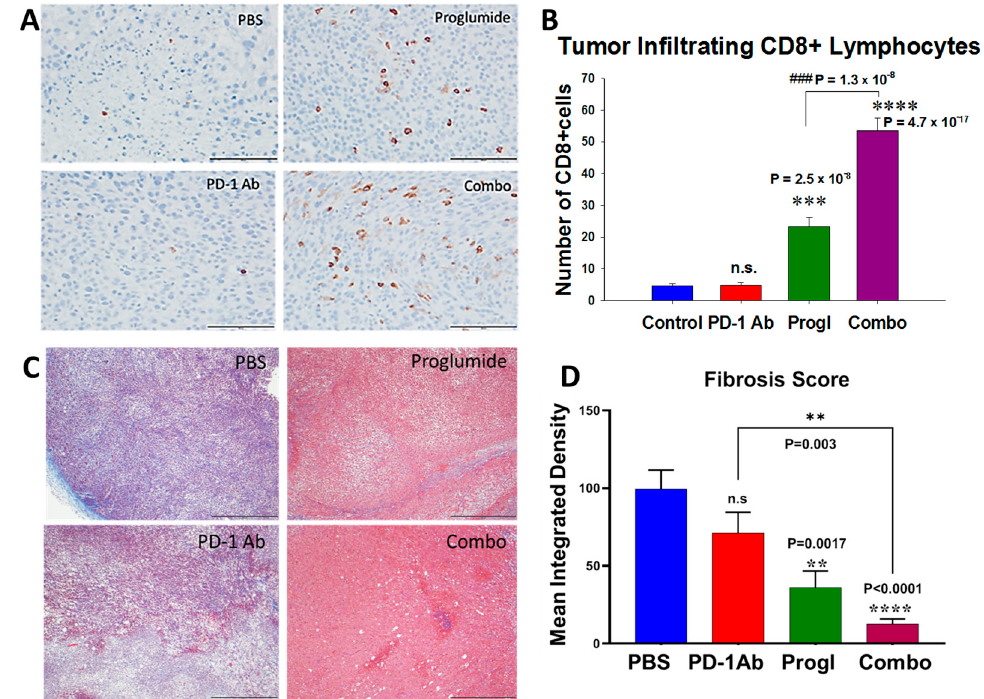
Figure 3. Effects of proglumide and the PD-1Ab on the HCC tumor microenvironment. ( A ) RIL-175 tumors were sectioned and reacted with an antibody to stain CD8+ T cells (Cell Signaling; Cat # 98941). A representative image of the immunohistochemistry from each group is shown. ( B ) Mean values ± SEM for number of CD8+ tumor infiltrating lymphocytes is shown. Only proglumide and the combination (Combo)-treated group had more tumoral CD8+ T cells than controls. The combination therapy was synergistic. (* compared to PBS and # compared to proglumide monotherapy vs. combination therapy.) Bar = 100 µm. ( C ) Masson trichrome staining of fibrosis in RIL-175 tumor sections is shown with representative images from each treatment group. ( D ) Tumoral fibrosis by Masson’s trichrome stain was analyzed by computerized densitometry. Only tumors of proglumide-treated mice had less fibrosis compared to controls. ( p values as shown.) Bar = 500 µ m; n.s. = not